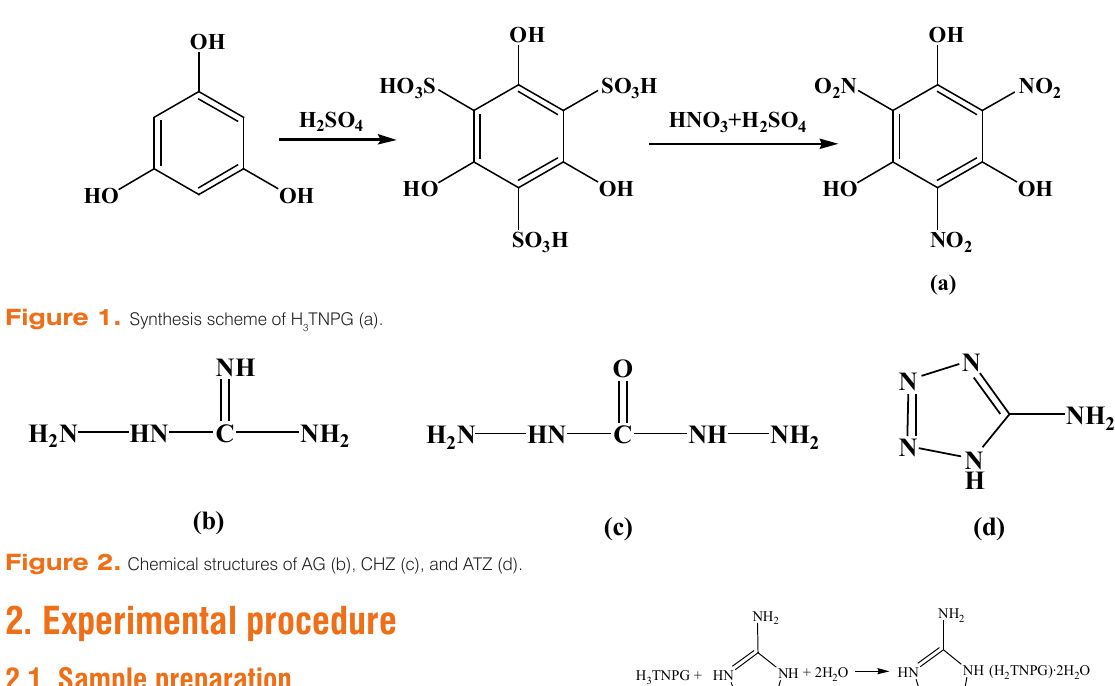
Figure 1. Synthesis scheme of H